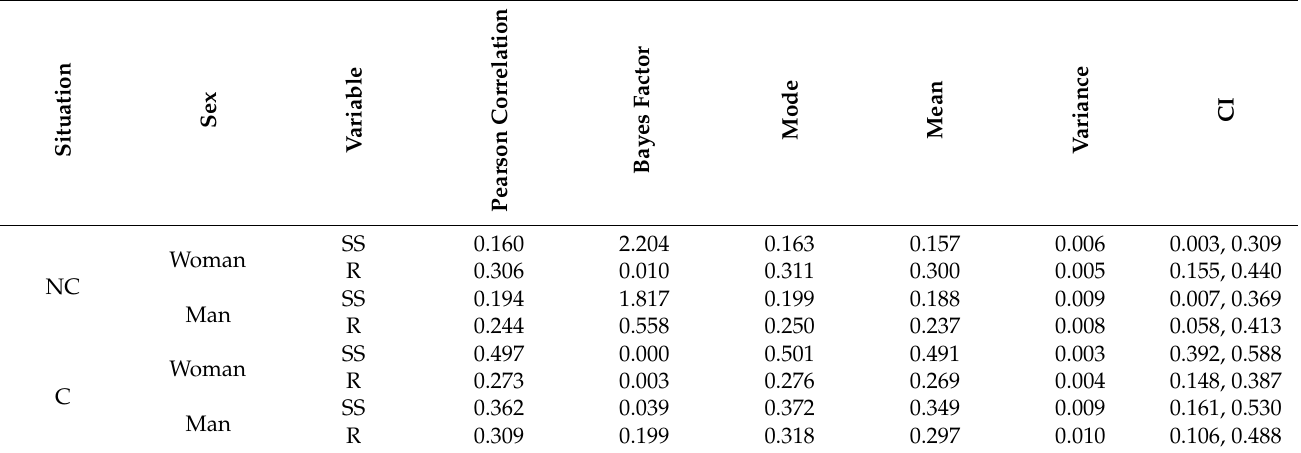
Table 2. Bayesian correlation matrix with prosocial